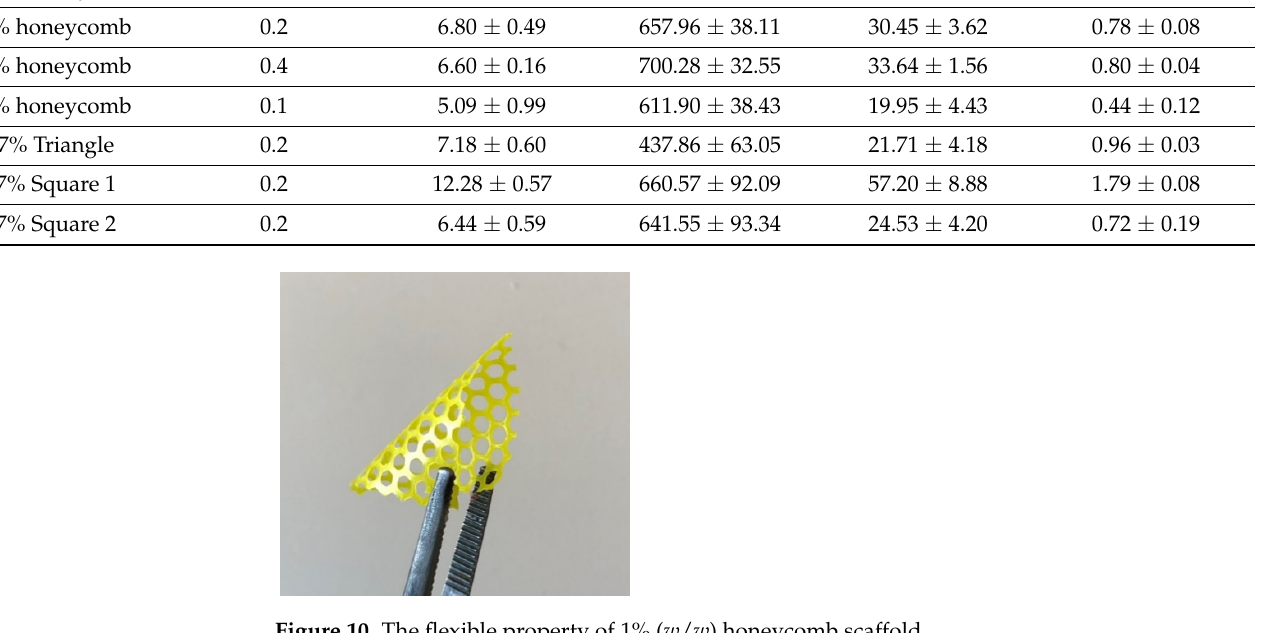
Table 4. Mechanical parameters of the blank honeycomb scaffold, 7% ( w / w ) honeycomb scaffolds with thickness 0.1, 0.2, and 0.4 mm; 7% ( w / w ) triangle, square 1, and square 2 scaffolds with thickness 0.2 mm ( n = 5 per group). Scaffold Blank honeycomb